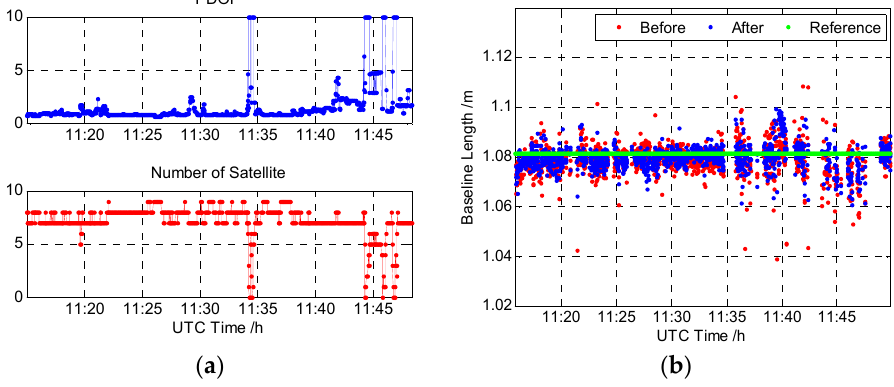
Figure 16. The urban vehicle test result: ( a ) the Position Dilution of Precision (PDOP) and the total satellite number; ( b ) the baseline length of the urban vehicle test.